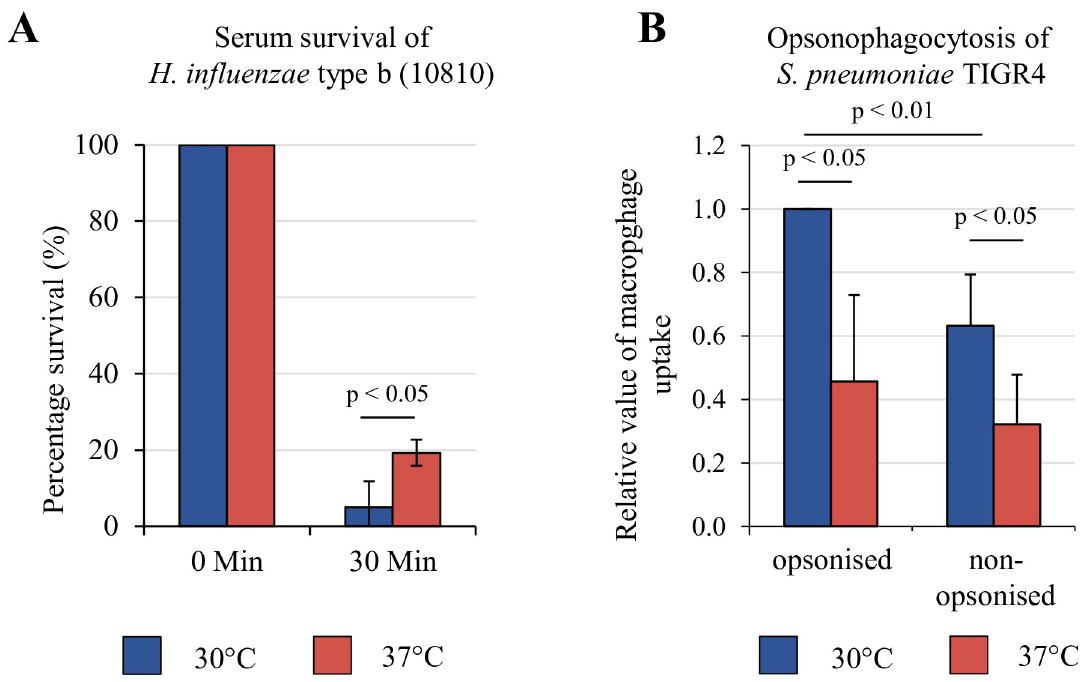
Fig 1. Temperature influences serum killing and opsonophagocytosis of H . influenzae and S . pneumoniae , respectively. (A) Serum killing of H . influenzae type b was measured by pre-incubating the bacteria at 30˚C or 37˚C in RMPI for 1 hour prior to addition of 25% pooled human serum. The mixtures were subjected to serum killing at 37˚C for 30 minutes. H . influenzae type b pre-incubated at 37˚C shows higher resistance to complement-mediated killing than bacteria at 30˚C. (B) The effect of temperature on opsonophagocytosis of pneumococci by THP-1 macrophages was analysed by growing S . pneumoniae TIGR4 bacteria at either 30˚C or 37˚C. The bacteria were then opsonised with pooled human serum for 30 minutes at 37˚C. Non-opsonised bacteria were exposed to only RPMI for 30min at 37˚C. Pneumococci grown at 37˚C are more resistant to phagocytosis by macrophages than bacteria grown at 30˚C. Error bars denote s.e.m. Statistical significance calculated using a paired, two-tailed student t-test.